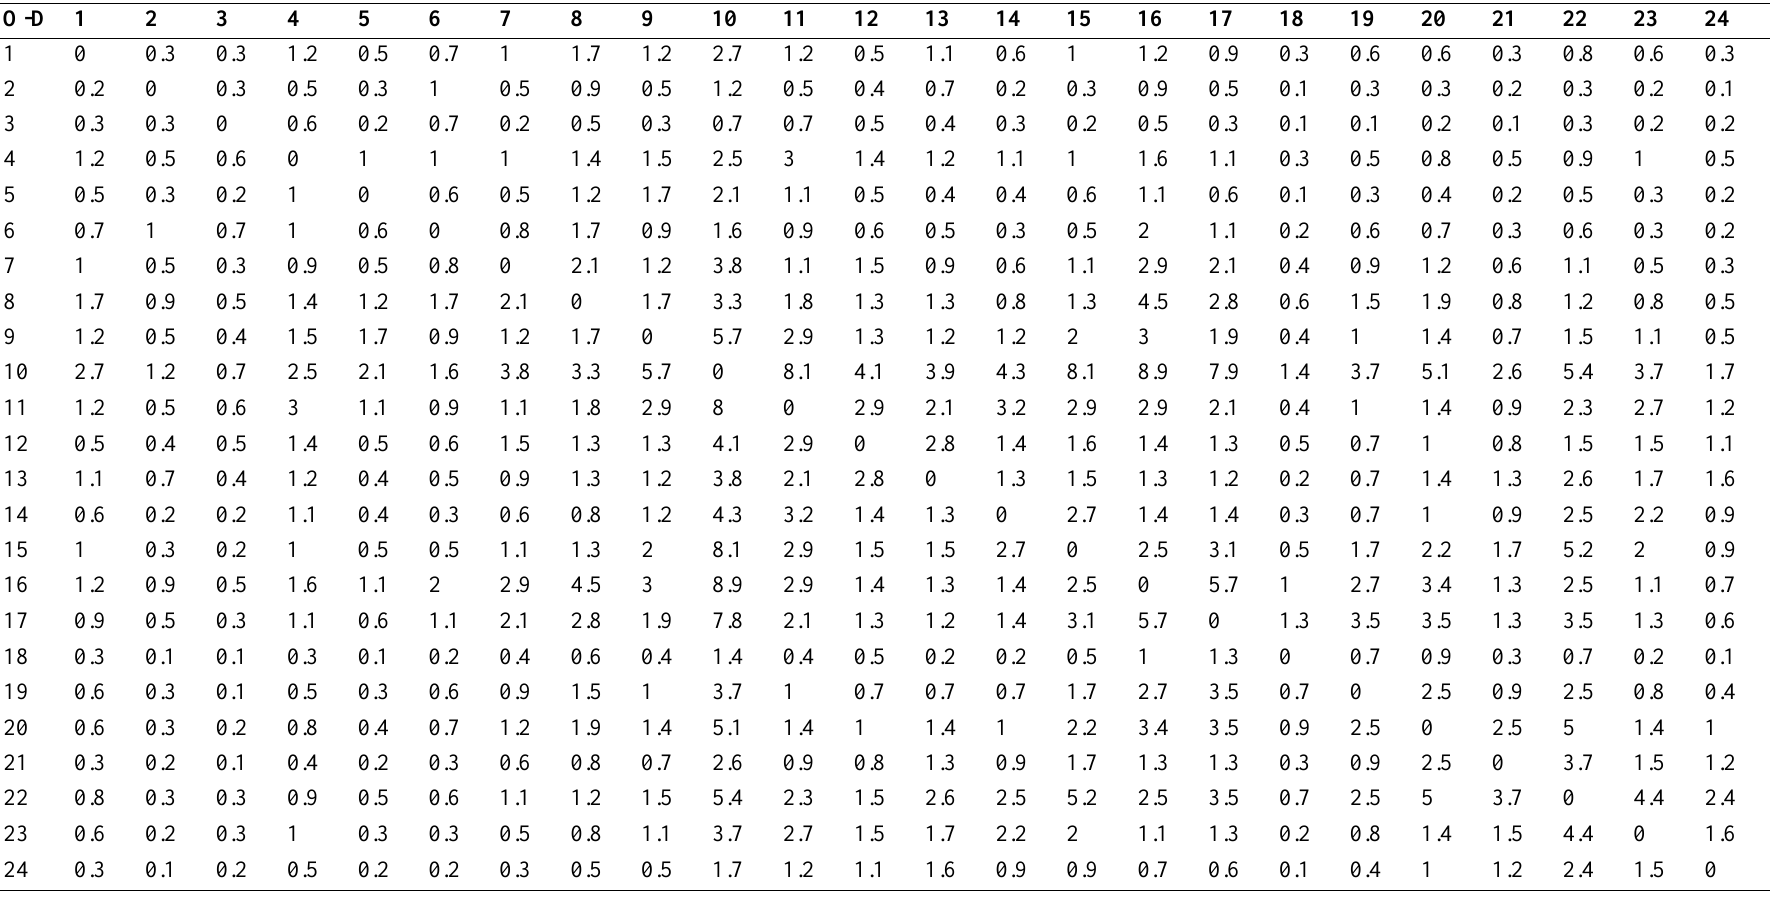
Table 5. O/D travel demand for Example Network 2 (thousands of